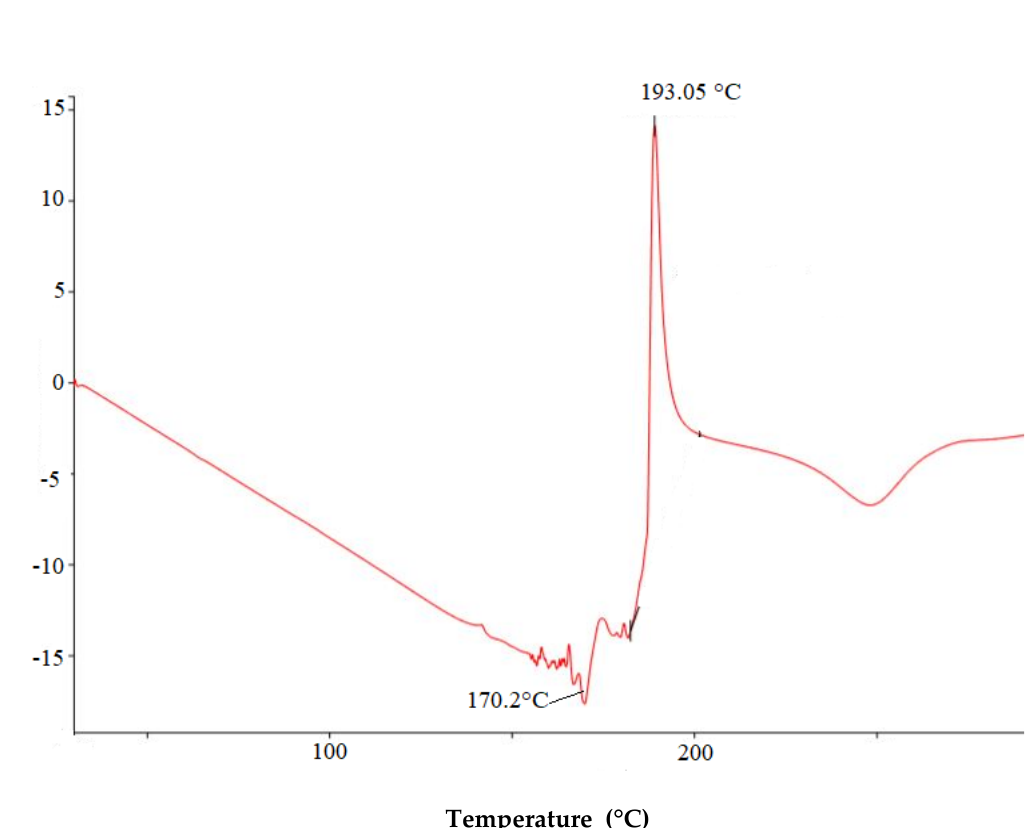
Figure 3. DSC curves of ( A ) Free curcumin, ( B ) GA polymer, ( C ) ALG polymer, ( D ) ALG-GA nanoparticles, ( E ) Cur / ALG-GANPs.